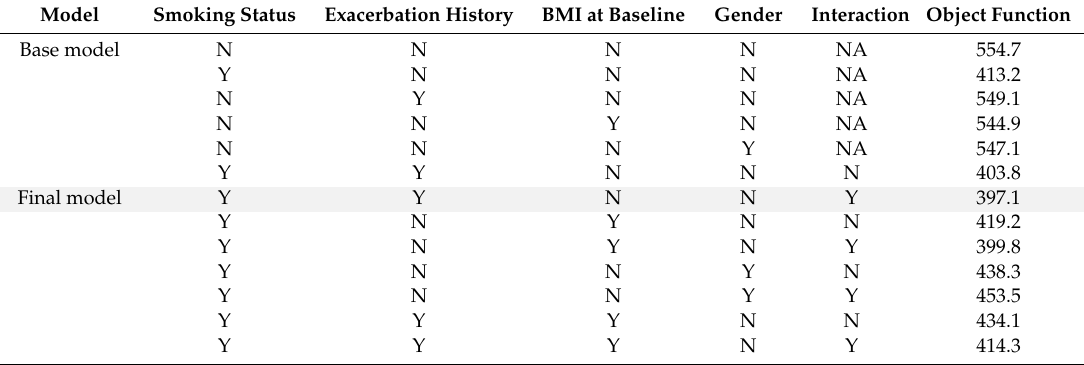
Table 2. Process of covariate selection of SReFT analysis considering change in object